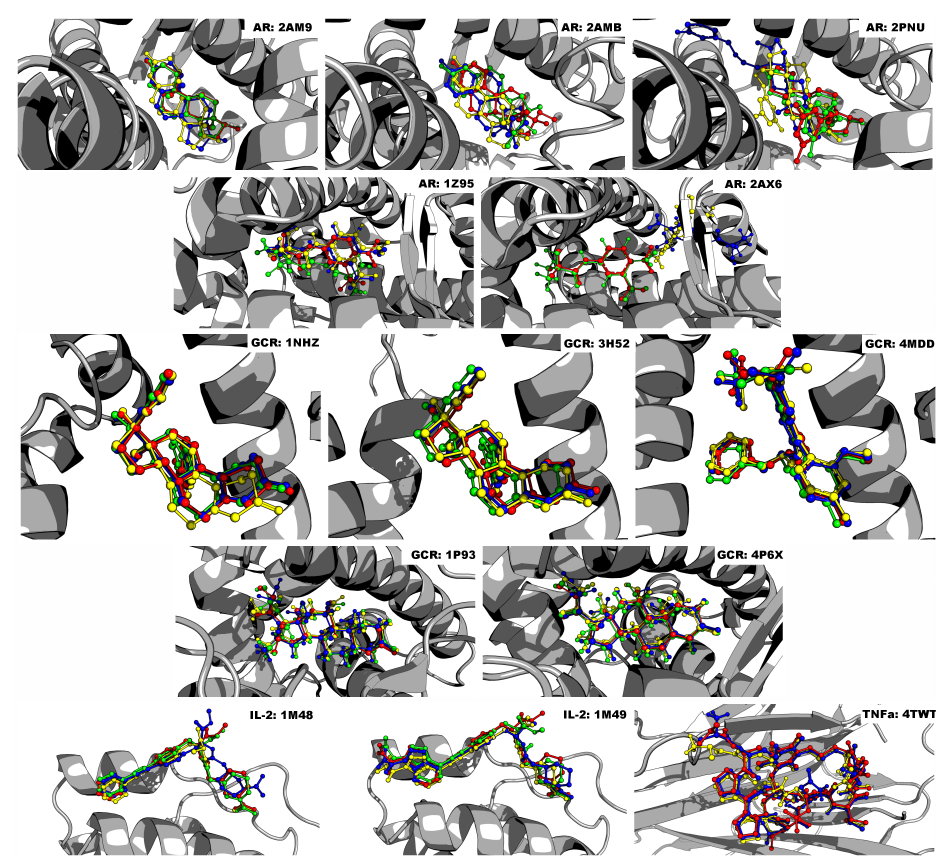
Figure 2. Docked poses of known binders to their targets. Known binder (red) compared to AD4 (yellow), VINA (blue), and GLIDE (green). Note that Residues 636–652 of GCR, and the hydrogen atoms on each ligand, are not shown for